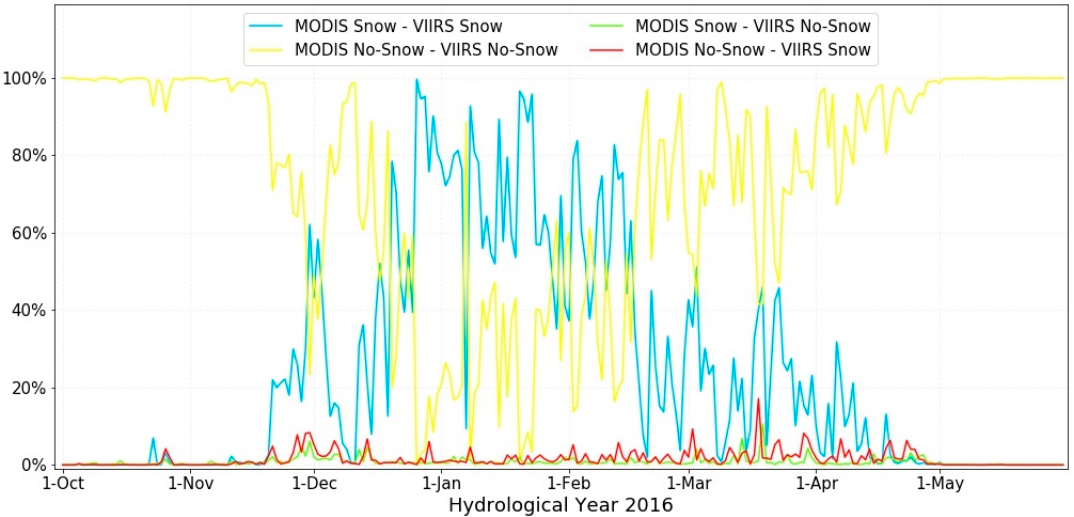
Figure 6. Line plots illustrating MODIS snow – VIIRS snow agreement, MODIS no-snow—VIIRS no-snow agreement, MODIS snow—VIIRS no-snow omission and MODIS no-snow—VIIRS snow commission with respect to each day of the 2016 hydrological year.